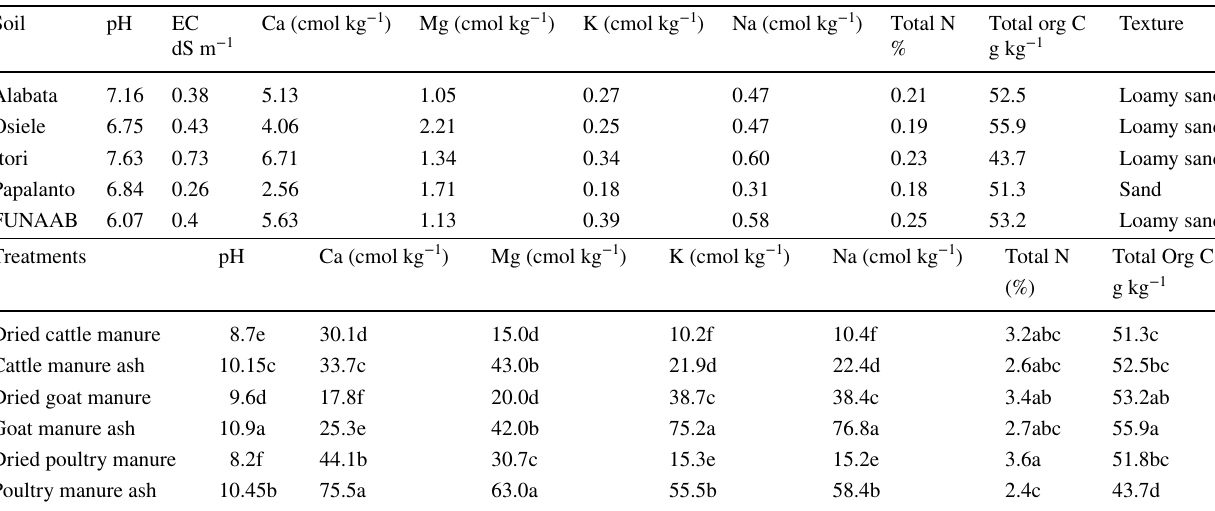
Table 1 Characterization of experimental soils, dried manures and manure ashes